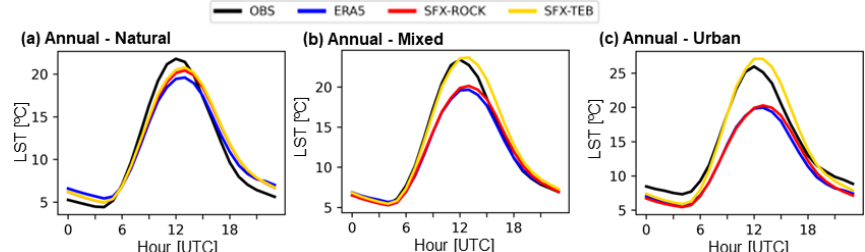
Figure 4. Average diurnal cycle of LST computed over the 2004–2018 period from LSA-SAF (black), ERA5 (blue), SFX-ROCK (red), and SFX-TEB (yellow) for grid boxes classified as (a) natural surfaces (grid boxes with urban fraction below 0.33), (b) mixed surfaces (grid boxes with urban fraction between 0.33 and 0.66), and (c) urban surfaces (grid boxes with urban fractions above